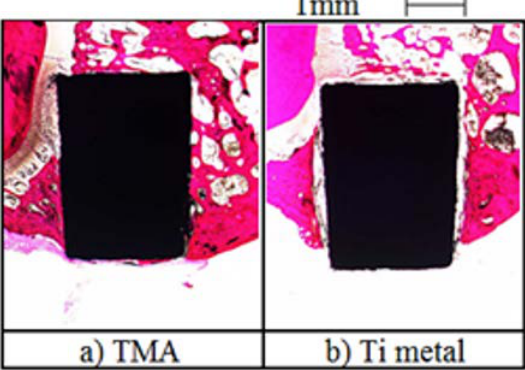
Figure 2. Histological evaluation in the presence of sintered TMA vacuum-sintered body and pure Ti metal after 1 month.